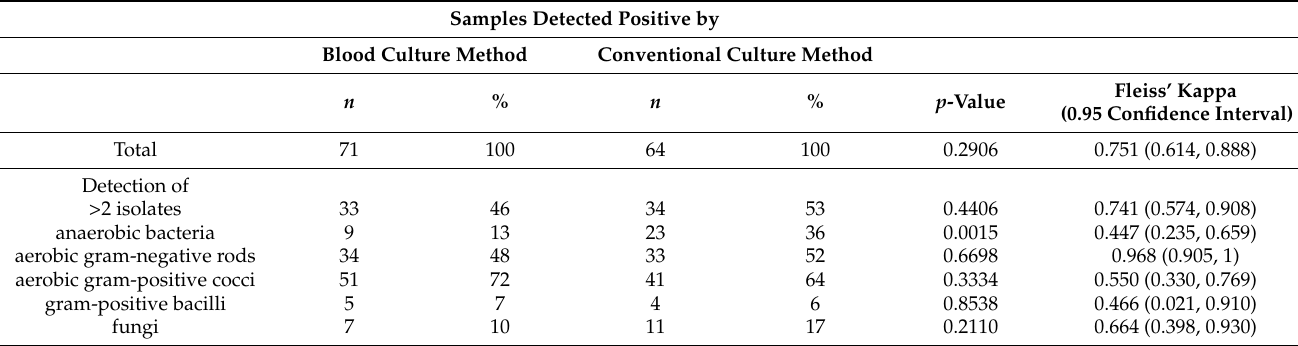
Table 4. Concordance of microbiological results between blood culture and conventional method.